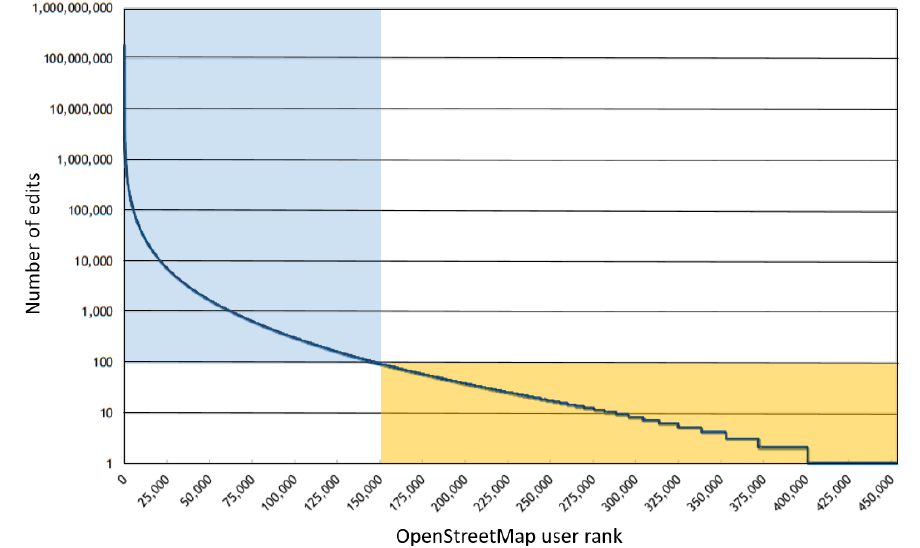
Figure 2. Participation inequality in OpenStreetMap adapted from Wood’s analysis [37]. The figure shows the number of users that contributed at least one edit. It illustrates that most of the contributions are performed by a small number of users. Only about 150,000 users (out of 2 million registered users at the time of analysis) contributed more than 100 points of data (blue side); the remaining users collectively contributed less than 100 edits (orange side).